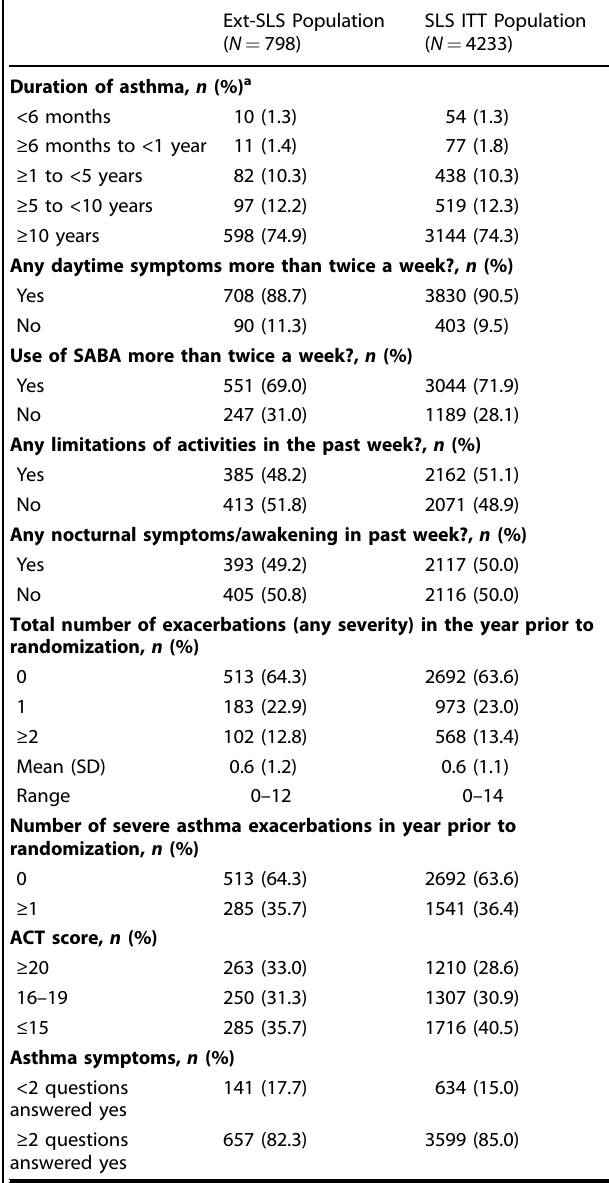
Table 3. Asthma disease characteristics in the Ext-SLS cohort and SLS ITT populations, captured at entry to the SLS.